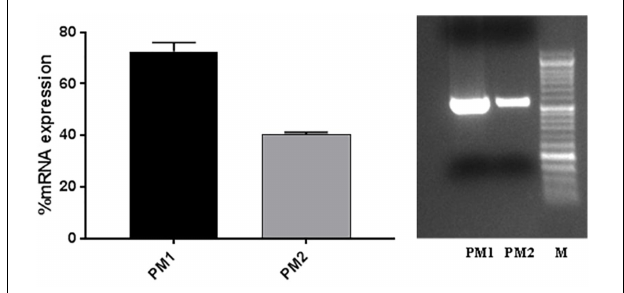
FIGURE 2 | ZapA gene expression in PM1 and PM2 growth in LB broth; data are expressed as percentages of mRNA levels in each sample normalised to 16S RNA. Data are mean ±